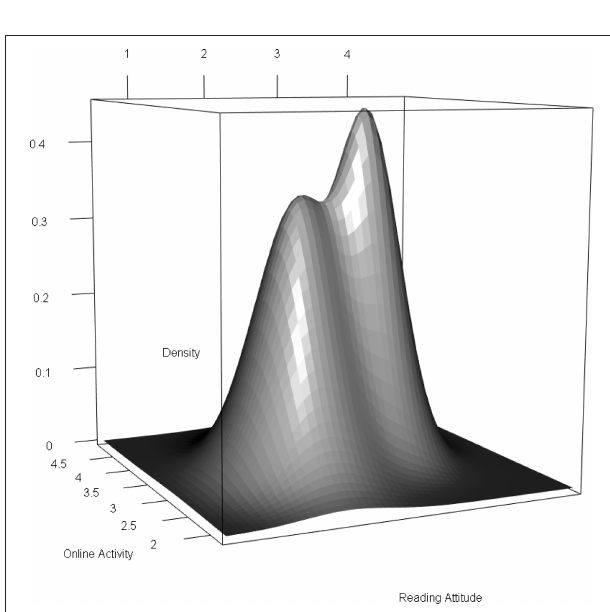
FIGURE 3 | Nonnormal bivariate distribution of the latent predictors.